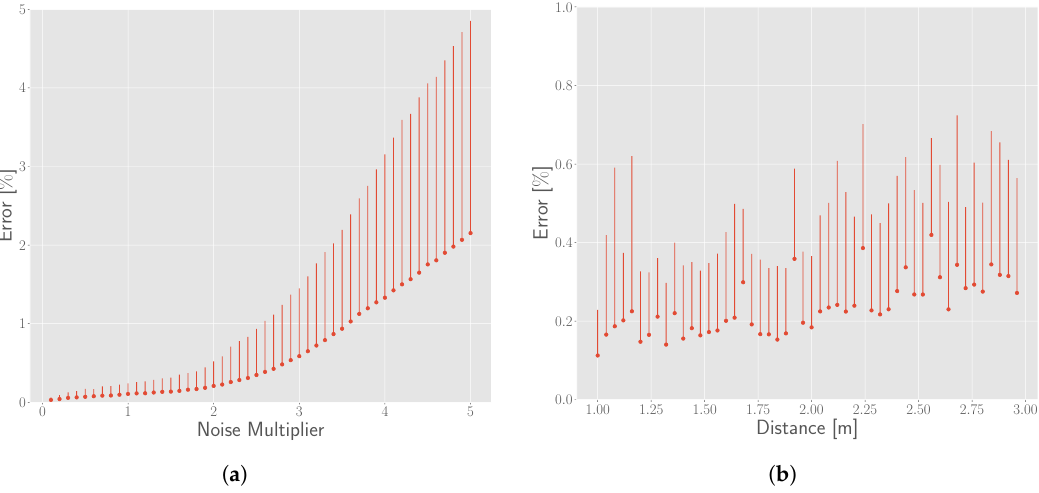
Figure 13. Corner detection error by simulation. The horizontal axes represent different simulation conditions and the vertical axes represent the relative error. Red points represent the mean value and the vertical lines represent the 3 σ range of the results simulated by 100 times at each simulation condition. ( a ) Relationship between the error and noise of the point cloud at 1 m. The x axis represent the multiplier for the noise baseline; ( b ) Relationship between the error and the distance of the chessboard with the baseline noise.